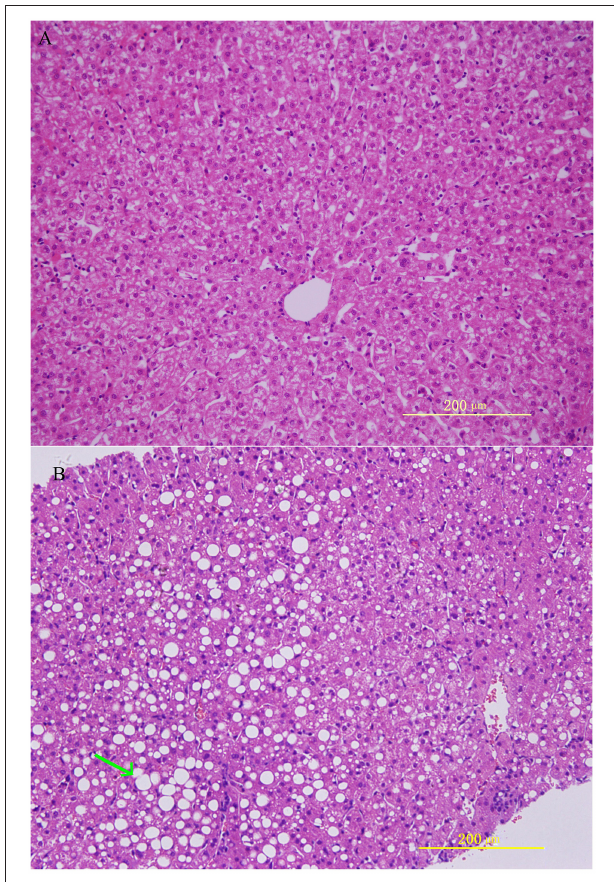
TABLE 1 | Information about control monkeys and monkeys with alcohol induced liver steatosis.